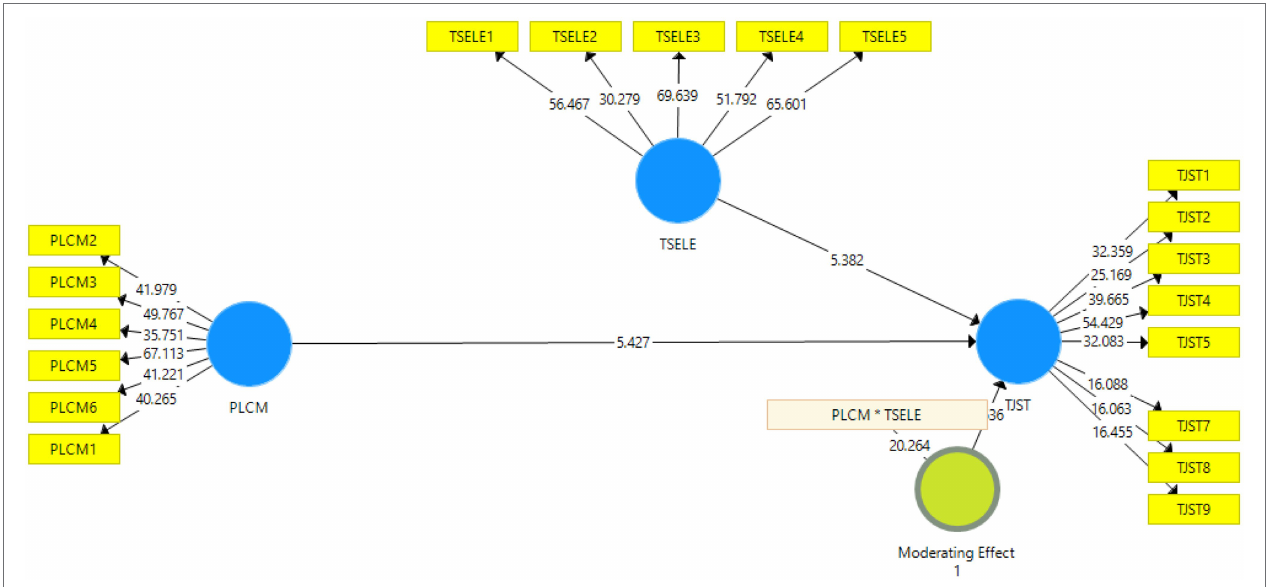
FIGURE 2 | Structural model.